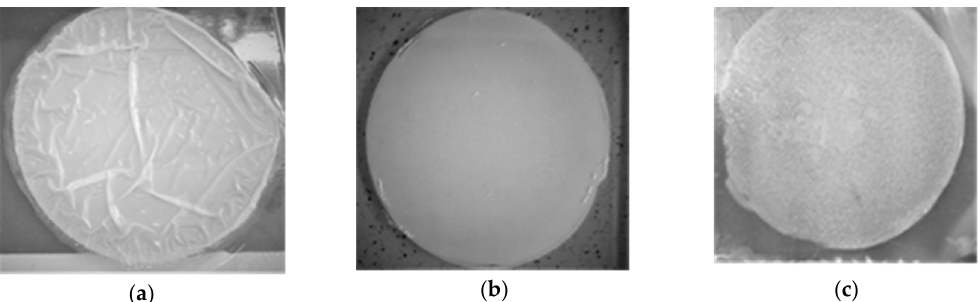
Figure 12. Comparison of water resistance of starting acrylic/styrene copolymer dispersion. ACR A ( a ), acrylic-silicone dispersion (ACR-SIL A-1) ( b ) and corresponding silicone-acrylic dispersion SIL-ACR ( c ). Samples were kept under water for 6 days. ACR A—deterioration of coating occurred, ACR-SIL A-1—coating did not change except for light whitening, SIL-ACR 1-A—coating changed significantly–numerous small bubbles.